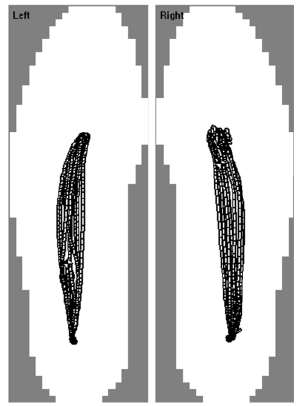
Figure 1. Typical plantar pressure derived centre of pressure paths for ST gait [36].